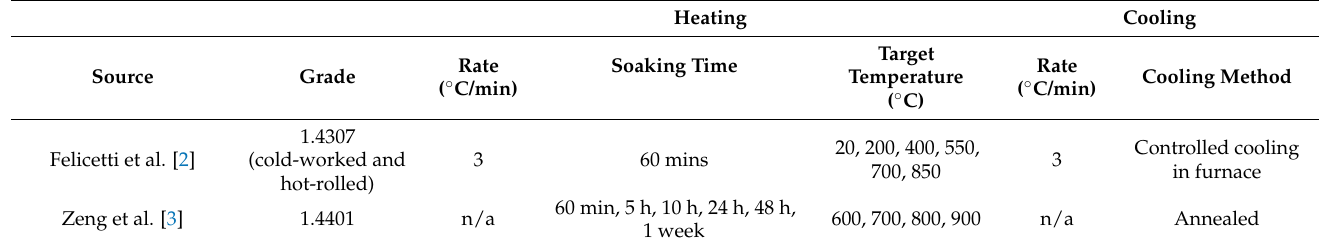
Table 1. Previous research into the behaviour of stainless steel